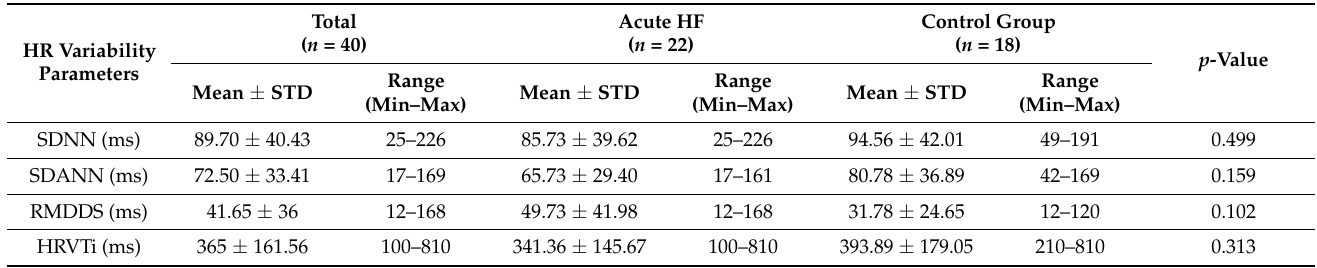
Table 10. Holter ECG monitoring: parameters of heart-rate variability in AHF and control